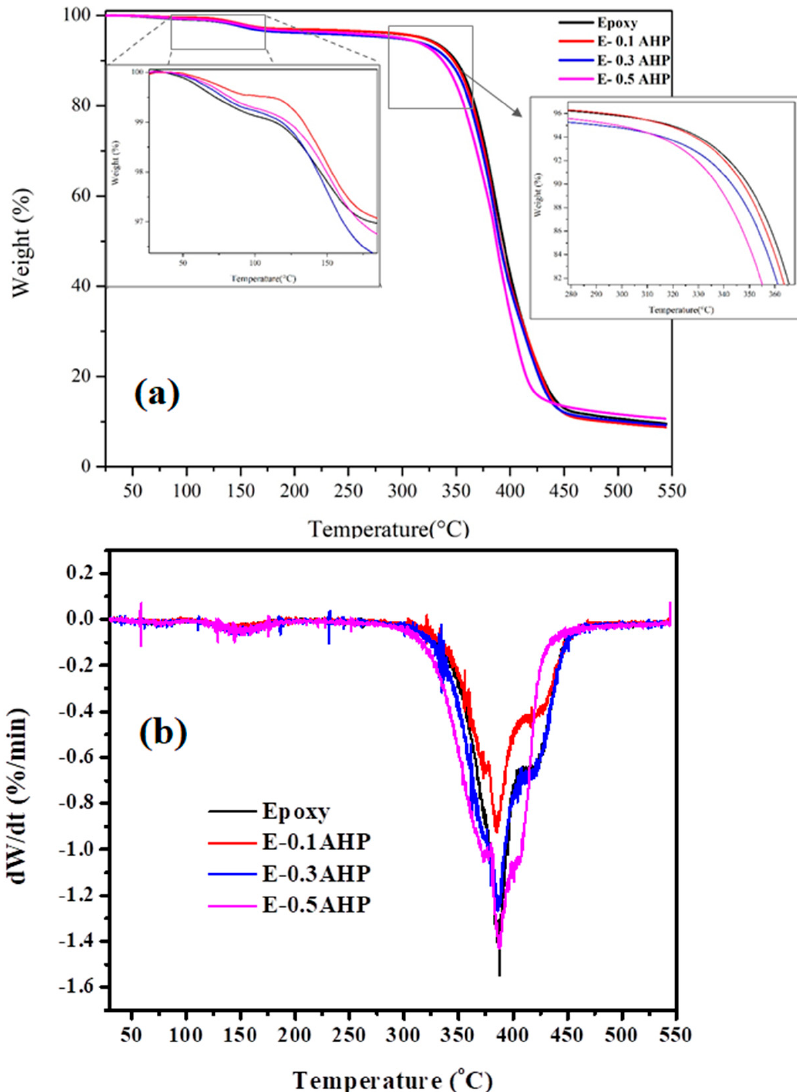
Figure 8. ( a ) TGA and ( b ) DTG thermograms of neat epoxy and its nanocomposites containing 0.1, 0.3 and 0.5 wt.% of and 0.5 wt.% of AHP. Table 5. TGA data of neat epoxy and AHP/EP nanocomposites.